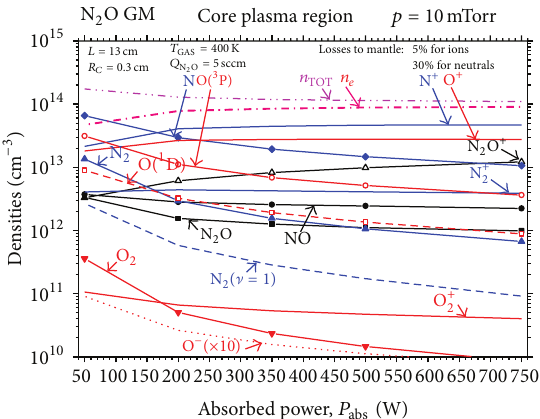
Figure 6: As in Figure 5 but for 𝑇 𝑒 , 𝑛 𝑒 , ionization percentage ( 𝜉 ), and remaining N 2 O percentage.